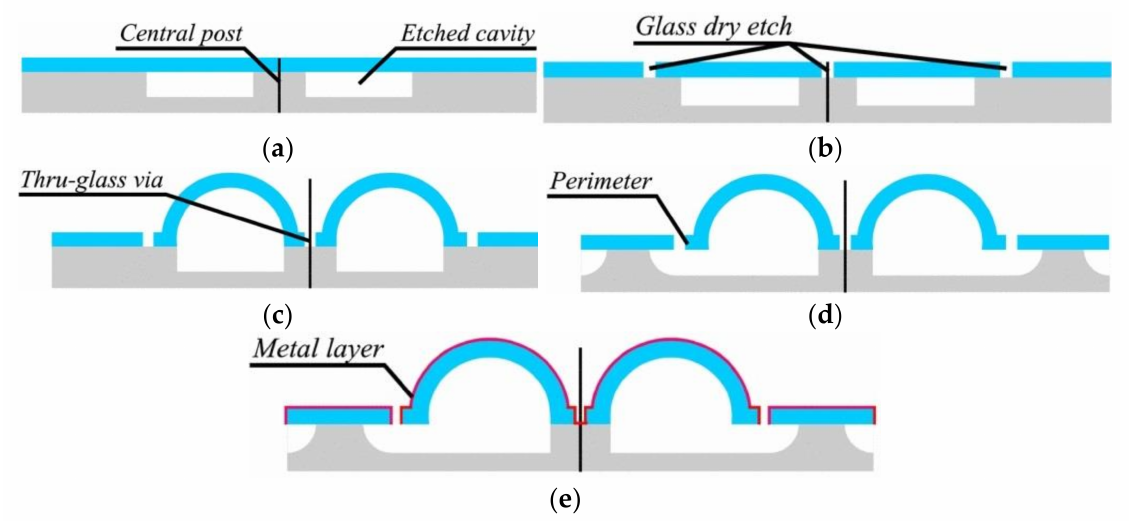
Figure 7. Step-by-step process flow diagram showing micro-glassblowing-based fabrication process of wineglass resonator with in-plane electrodes (Senkel et al. [86,90]) © 2022 IEEE. Reprinted, with permission from IEEE from D. Senkal, M. J. Ahamed, A. A. Trusov and A. M. Shkel, “Demonstra- tion of sub-1 Hz structural symmetry in micro-glassblown wineglass resonators with integrated electrodes”, in Transducers & Eurosensors XXVII: The 17th International Conference on Solid-State Sensors, Actuators and Microsystems (TRANSDUCERS & EUROSENSORS XXVII), Barcelona,